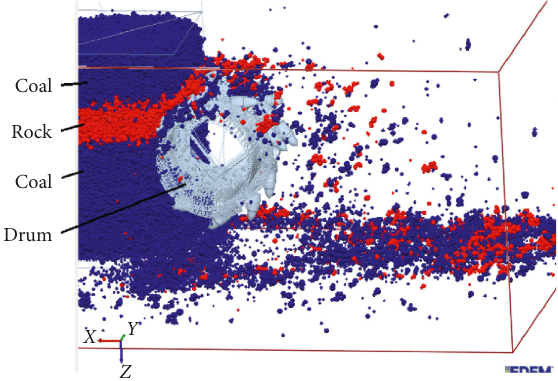
Figure 3: The model of the drum cutting coal containing a dirt